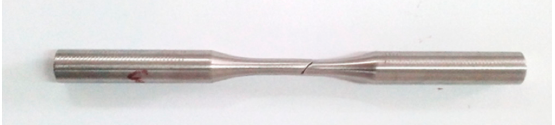
Figure 12. Fractured specimen (from the fatigue process, R = 0.25).